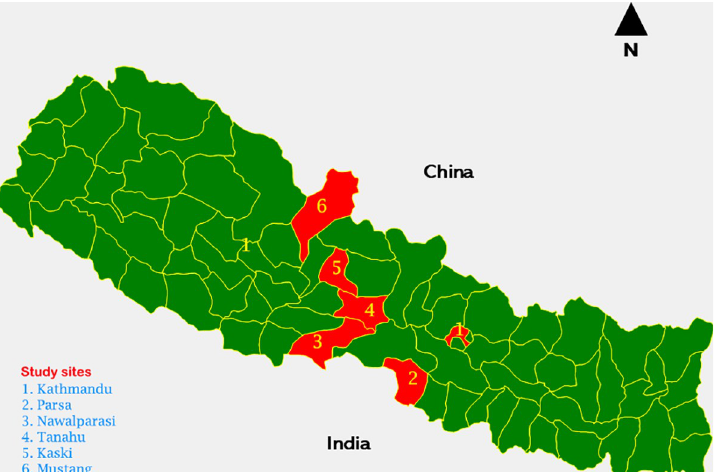
Fig 1. Study sites by geographic region and